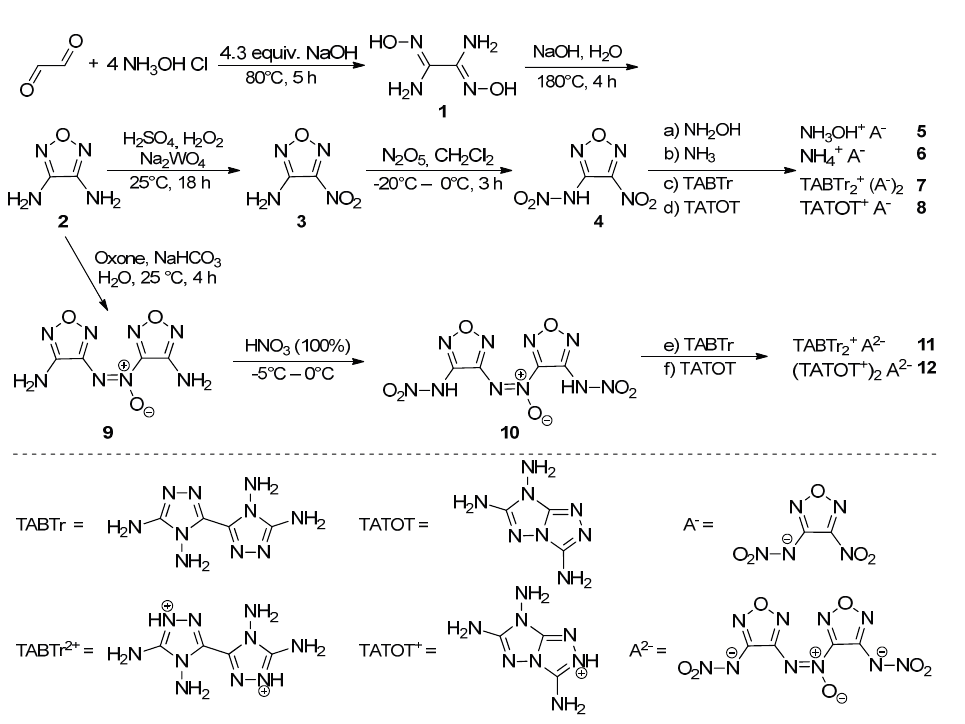
Figure 1. Synthesis of 3-nitramino-4-nitrofurazan 4 and dinitraminoazoxyfurazan 10 as well as their energetic